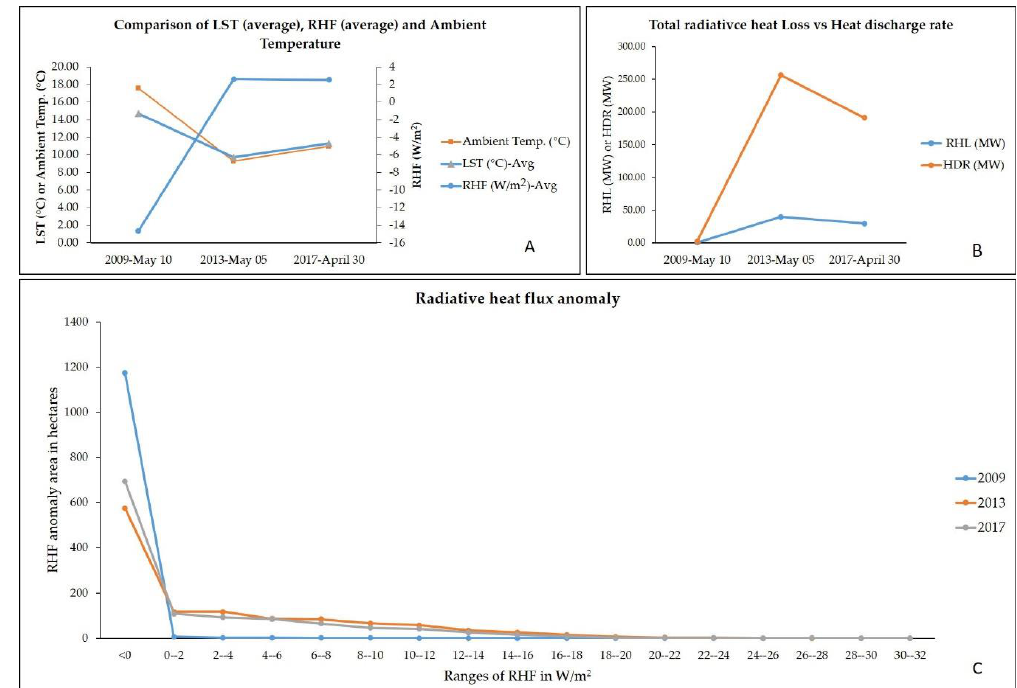
Figure 7. Changes in land surface temperatures (LST), radiative heat flux (RHF), and ambient temperature from 2009 to 2017 ( A ); RHF anomaly areas for 2009, 2013, and 2017 ( C ); and changes in total radiative heat loss (RHL) and heat discharge rate (HDR) from 2009 to 2017 for the Hatchobaru–Otake geothermal area ( B ).